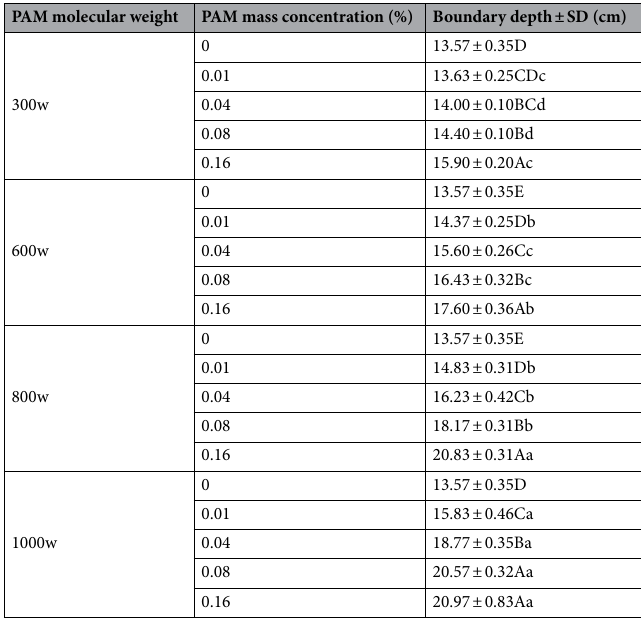
Table 2. Saturated boundary depth of soil water stratification for four molecular weight (300w, 600w, 800w and 1000w) and five mass concentration (0%, 0.01%, 0.04%, 0.08% and 0.16%) of PAM. S.D. means the standard derivation among the repetitions (n = 3). Different capital letters indicate the significant difference in saturated boundary depth of soil water under different mass concentrations of PAM with the same molecular weight of PAM, and different lowercase letters indicate the significant difference in saturated boundary depth of soil water under different molecular weight PAM treatments when the mass concentration of PAM is the same.